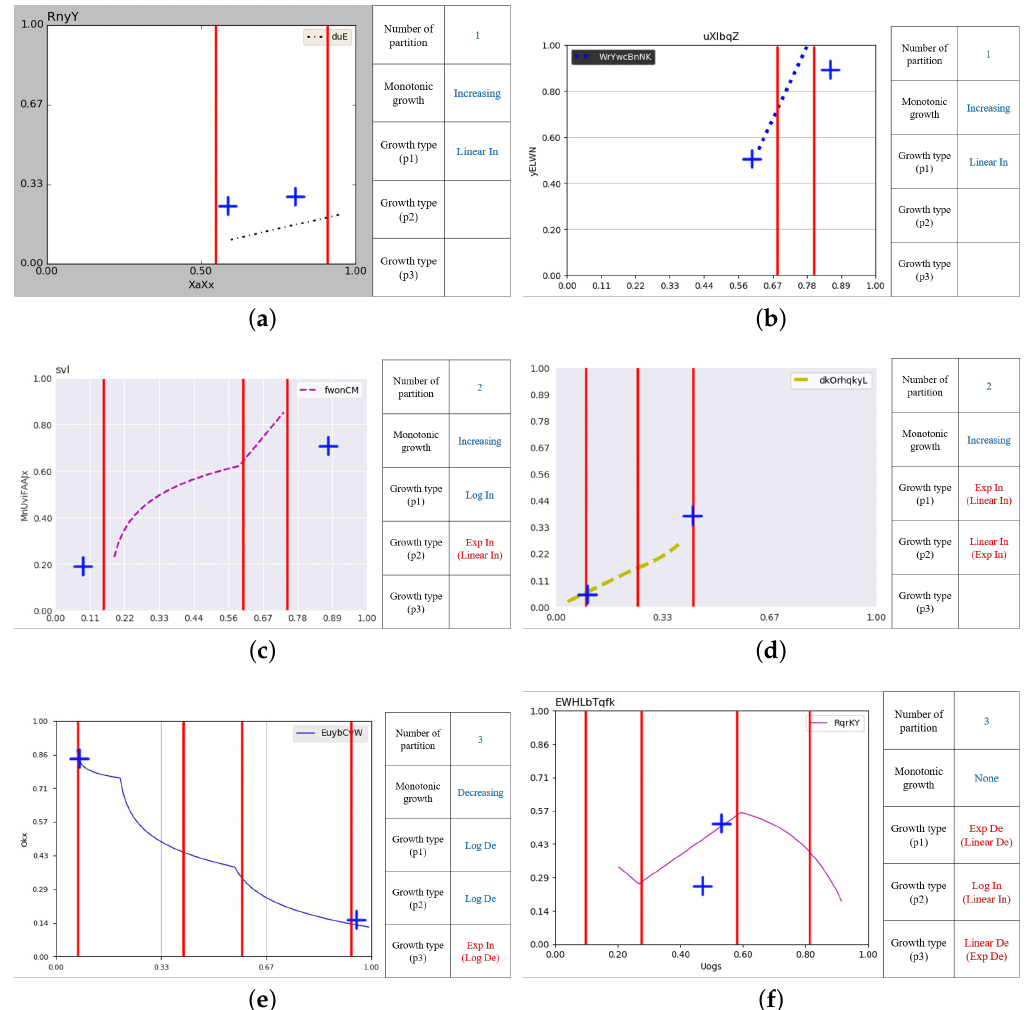
Figure 8. Example of detailed results on synthetic test dataset. Blue, correct prediction; red, wrong prediction; In, increase; De, decrease; blue cross, minimum and maximum point; red line:,partition boundary. These test data consist of one line chart, so superiority evaluation was